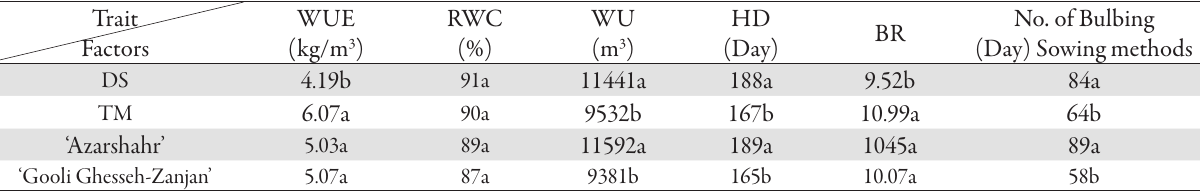
harvesting date, bulbing ratio and number of day bulbing